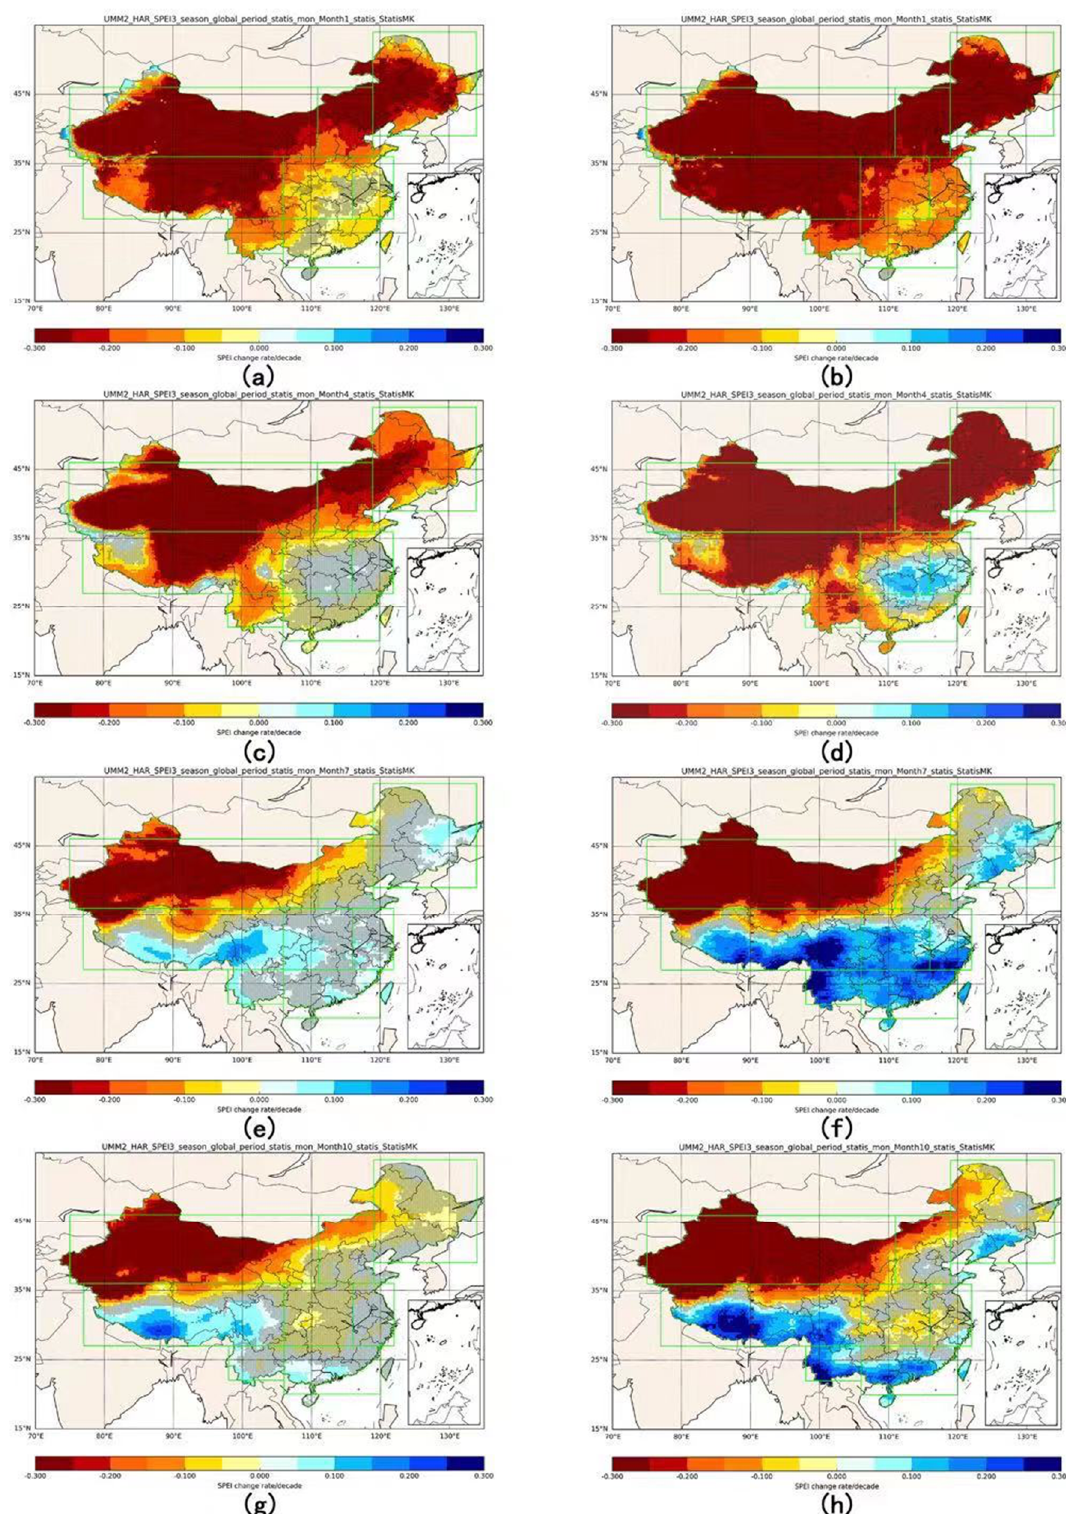
Figure 5. Spatial distribution of the projected four seasons using Sen’s slope estimates for decadal SPEI_3 changes during the period 2000–2100 (top row is winter, followed by spring, summer, and autumn) by using MME. Note that the cross-hatches represent no statistical significance at the 5% level for Mann–Kendall trends in these pixels.